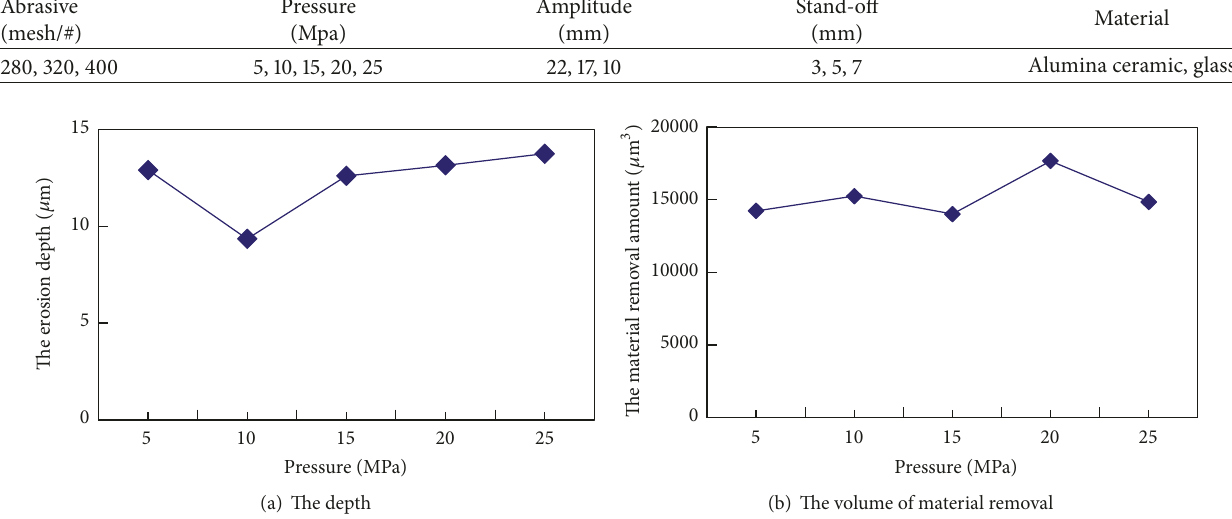
Figure 5: The effect of water jet pressure on the depth and the volume of material removal.